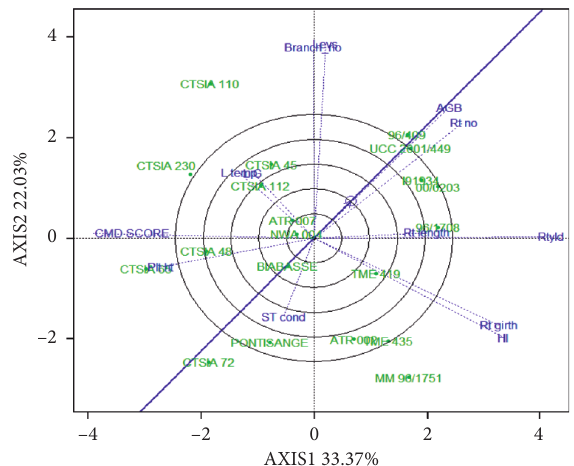
Figure 1: Vector view of the genotype × trait biplot on physio- logical traits of 20 genotypes of cassava showing the interrela- tionships among all traits in six environments. AGB � above ground biomass yield (t ha − 1 ), Branchno_plt � number of branches per plant, CMD (1–5) � cassava mosaic virus disease score (1 � healthy plant and 5 � highly diseased plant), HI ° � ° harvest in- dex, L: G ratio � storage root length :girth ratio, Leaf temp � leaf